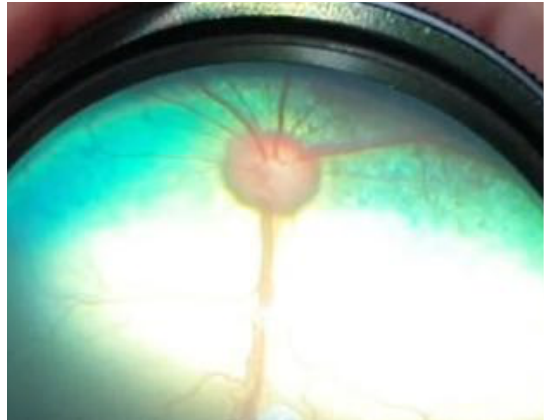
Figure 13. Normal appearance of the optic disc - pink with a physiologic pit centrally, retinal vessels are seen crossing the border of the optic disc (North Downs Specialist